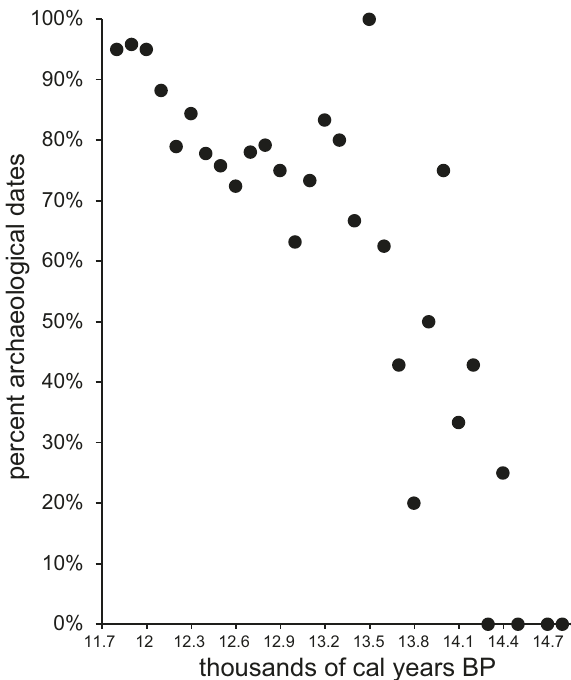
Fig. 1 | The percentage of archaeological dates associated with human occu- pation out of all dates in the archaeological dataset used by Stewart and colleagues ’ 2 after identifying non-archaeological dates associated with geoarchaeological studies, archaeological sites not widely agreed upon as legitimate, and other questionable contexts. Dates span 11.7 to 15 ka and are binned in 100 year intervals using the median calibrated age estimate. Archae- ological radiocarbon dates grow increasingly uncommon toward the past in the dataset used by Stewart and colleagues 2 , which has falsely extended the age of human occupation and overestimated human abundance for the earliest portions of the